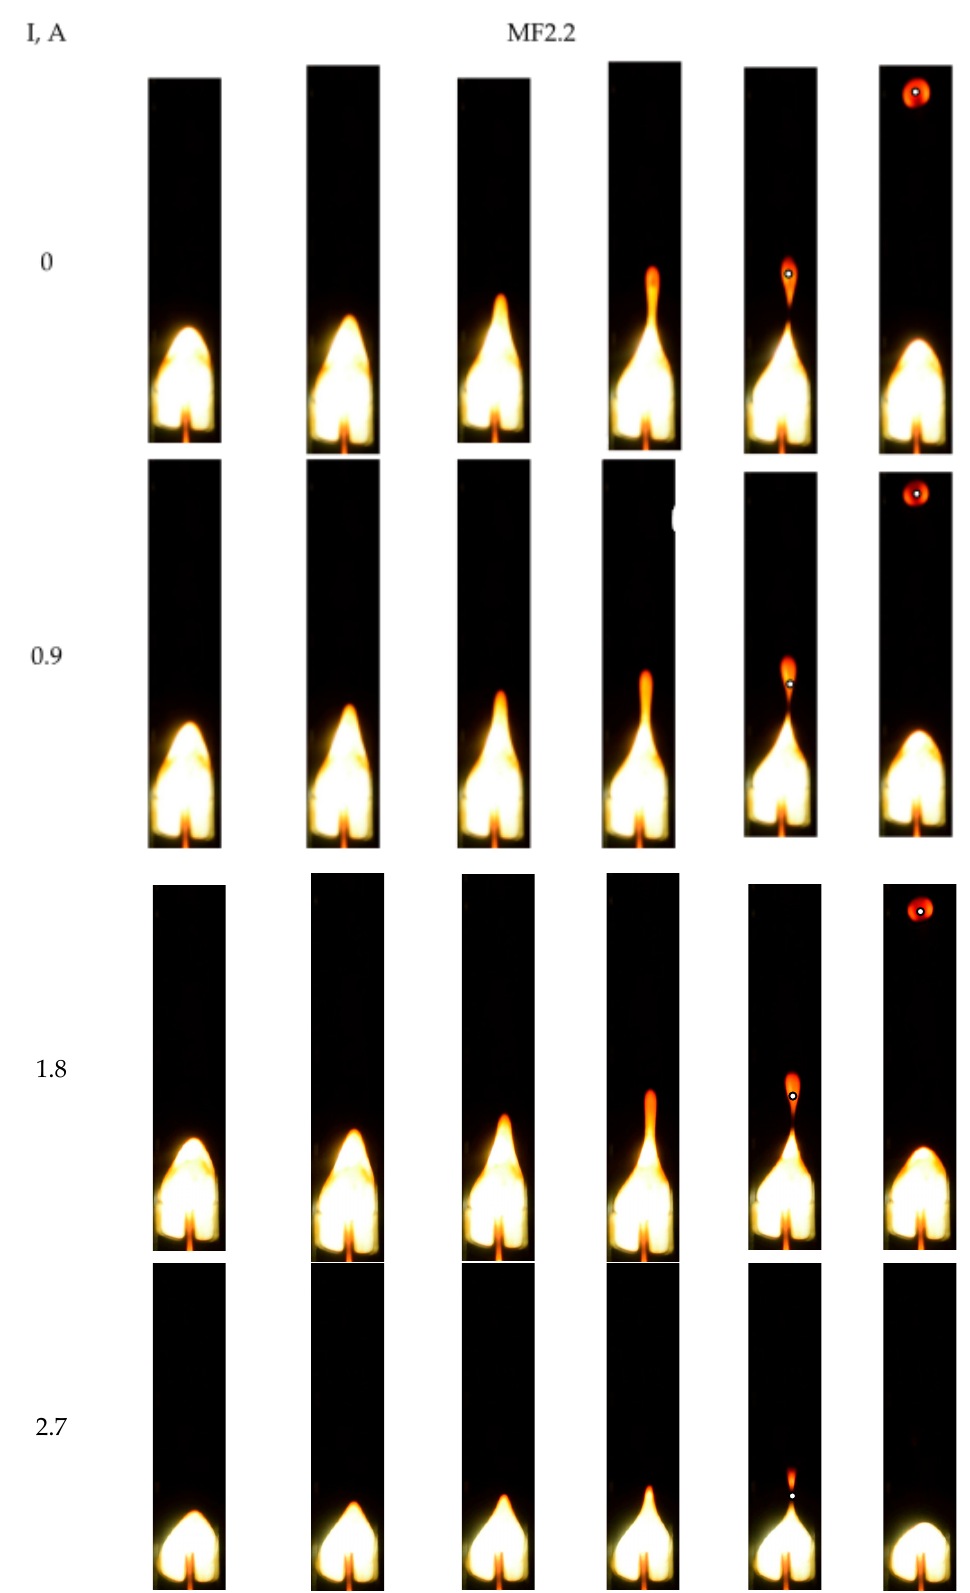
Figure 3. Dynamics of the interphase boundary “water-MF” for the specimen MF-2.